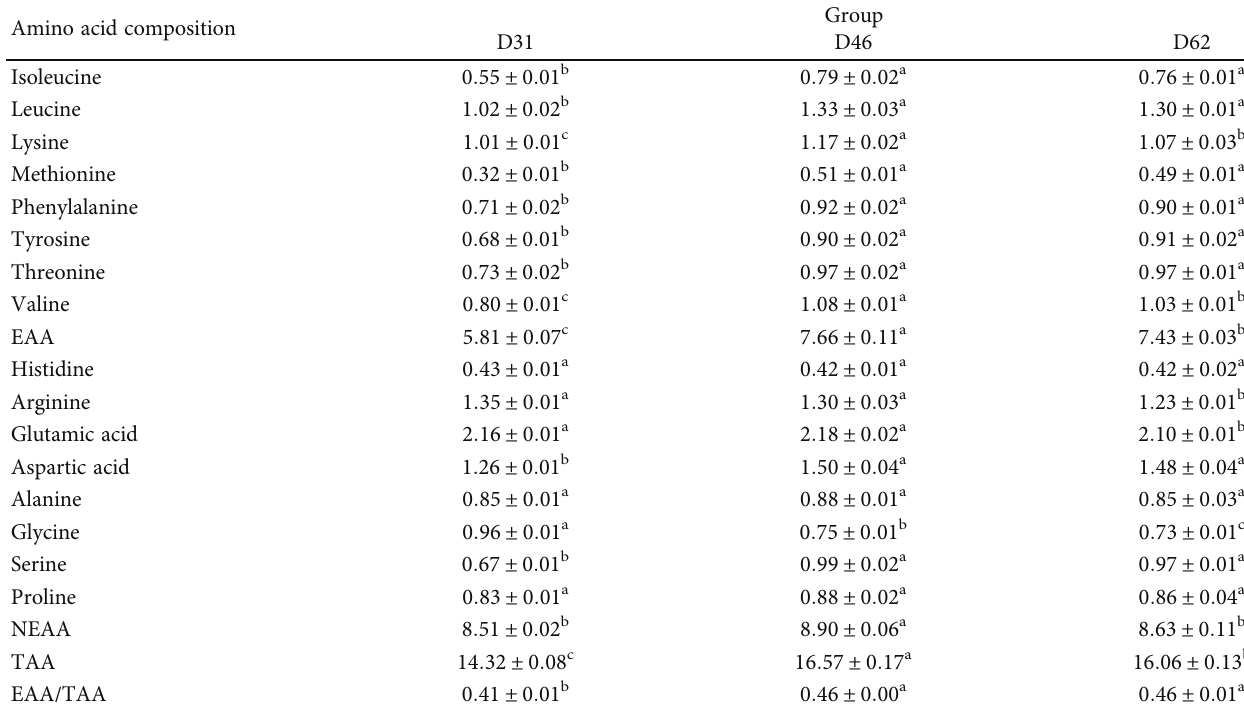
Table 6: Amino acid composition of female E. sinensis ovary in rice-crab coculture system at di ff erent developmental periods (% wet weight). Amino acid